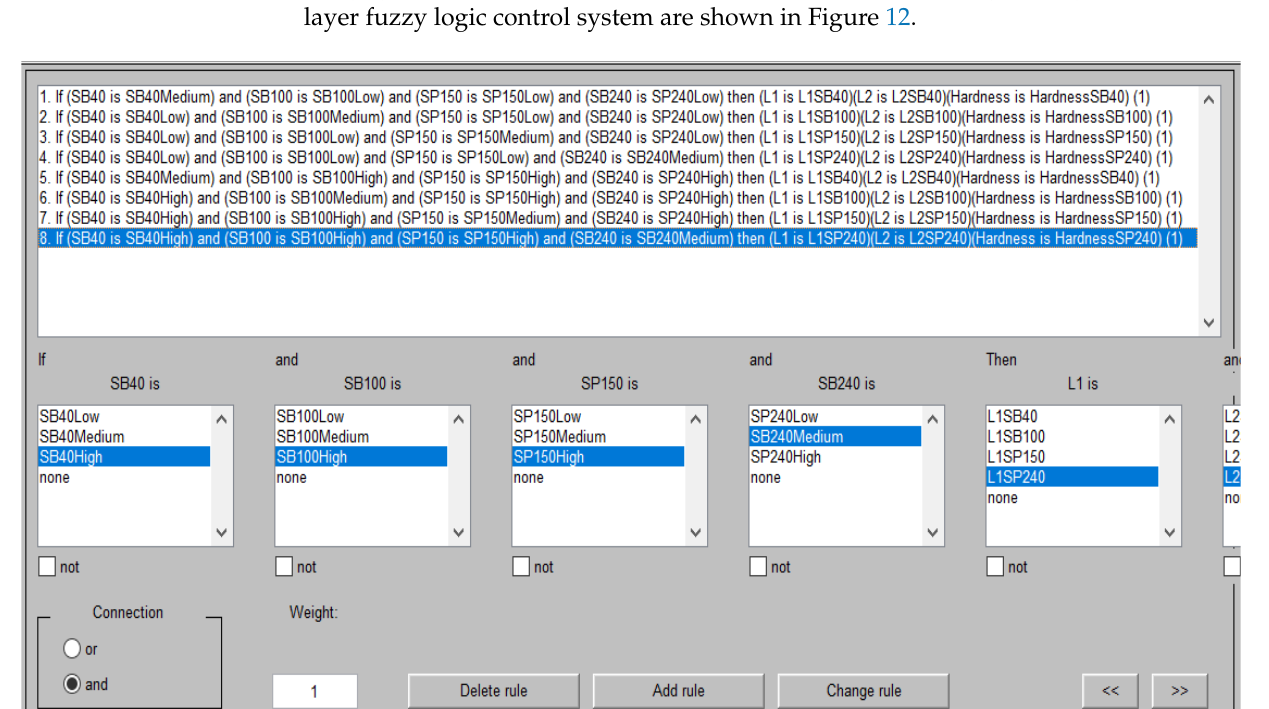
Table 5. Output results of fuzzy system.